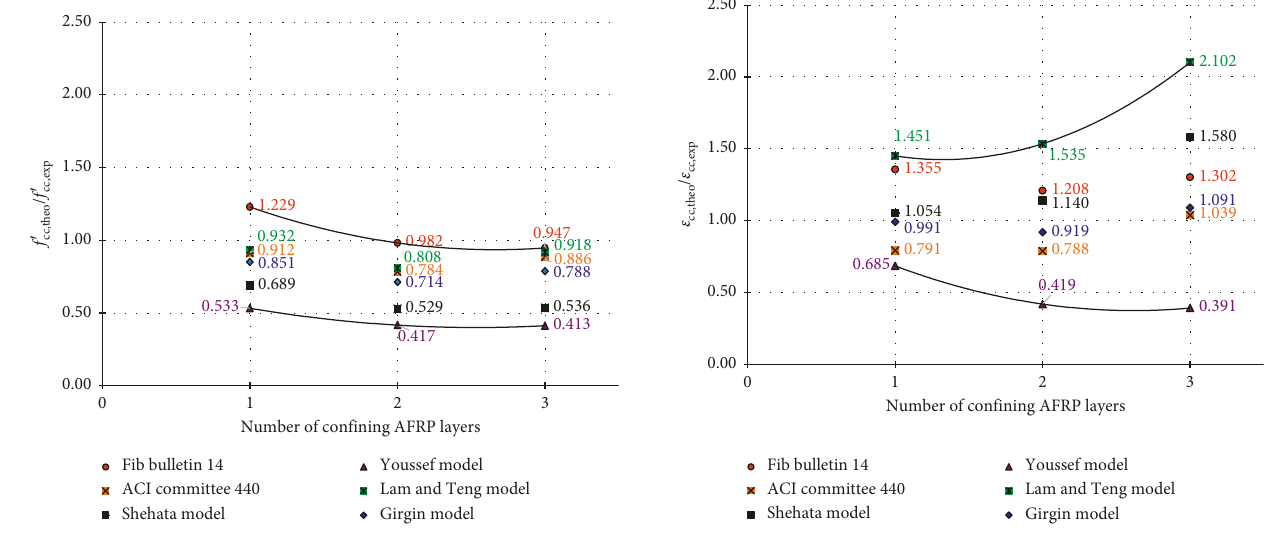
Figure 7: Normalized peak stress values. Figure 8: Normalized peak compressive